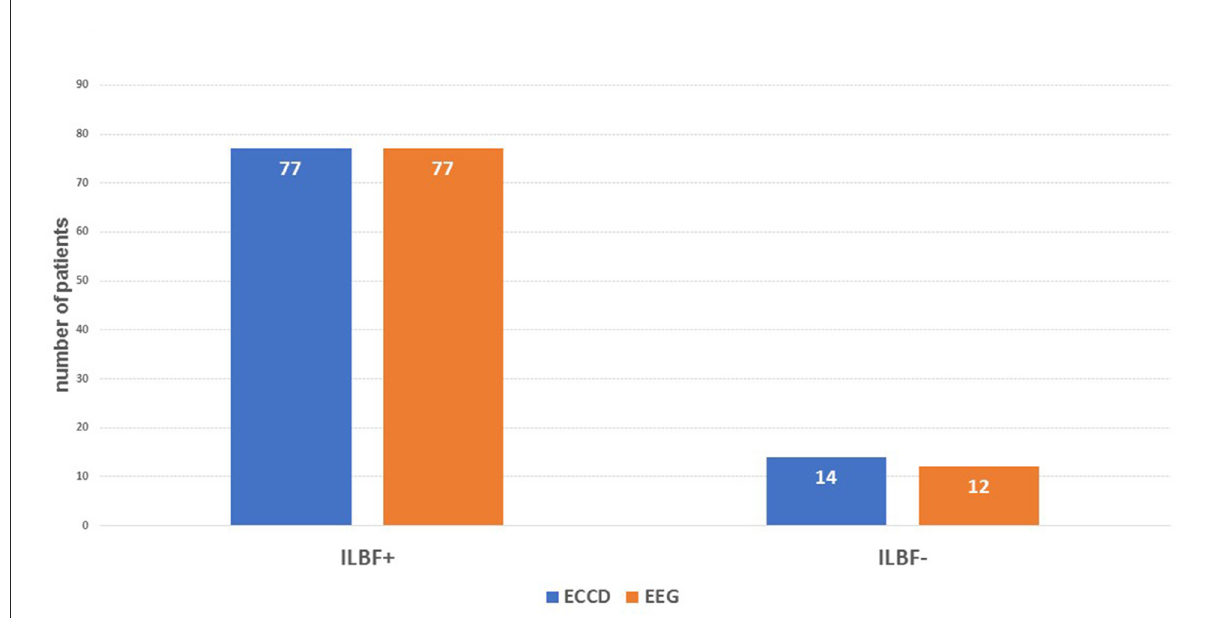
FIGURE3 The main results of the index test (ECD) compared to the gold standard (EEG). ILBF + , result consistent with ILBF; ILBF-, result inconsistent with ILBF. The resulting specificity is 1.0, positive predictive value is 1.0, sensitivity is 0.975, and negative predictive value